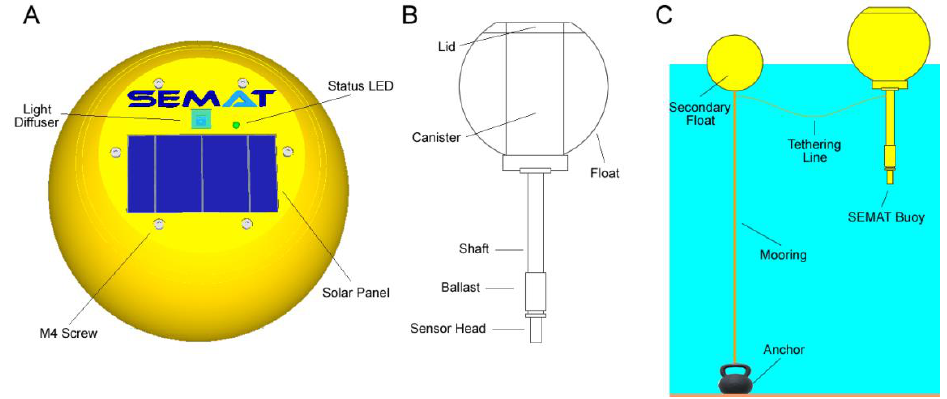
Figure 2. ( A ) SEMAT Buoy (Top View); ( B ) Buoy Cross Section; ( C ) Anchor and Mooring System.